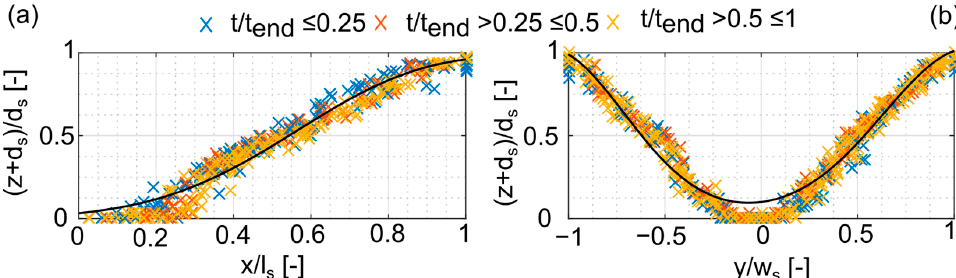
Figure 15. Scaled scour hole cross sections at different time intervals: ( a ) longitudinal (l s to d s ) and ( b ) horizontal (w s to d s ). ( b ) horizontal (w s to d s ).